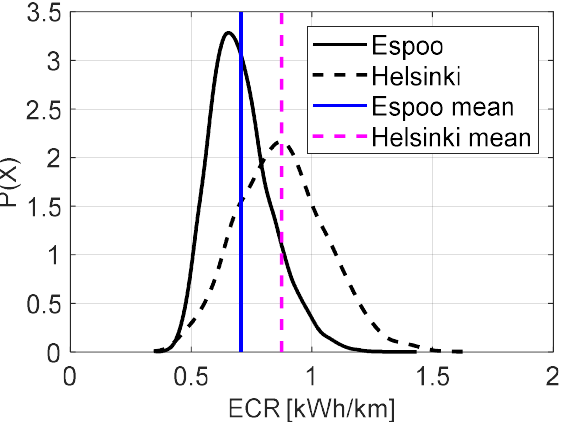
Figure 13. The probability density functions of ECR in suburban (Espoo) and city (Helsinki) routes.